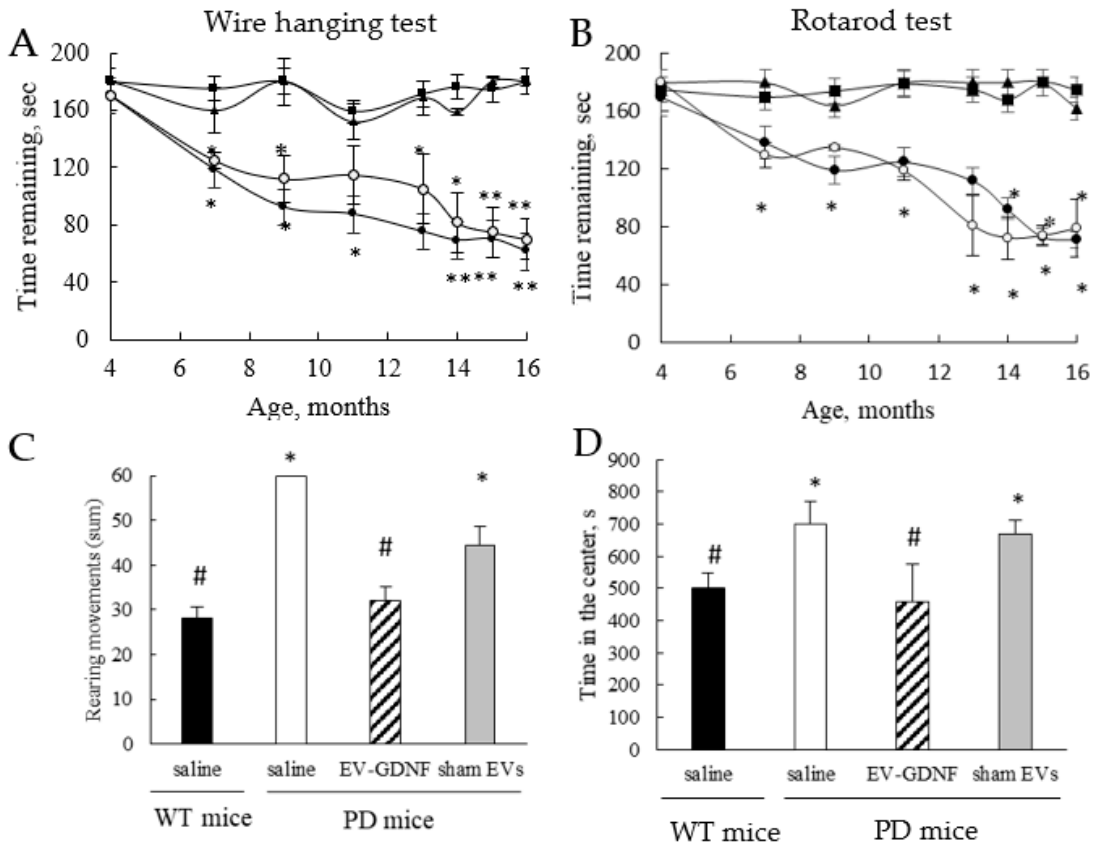
Figure 3. Behavioral tests demonstrating significant therapeutic effect of EV-GDNF in Parkin-Q311X(A) mice. The effect of EV-GDNF on motor functions and activity was assessed in a wire-hanging test and rotarod test ( A , B ), as well as in OFA tests ( C , D ). ( A , B ) Transgenic mice were i.n . injected with EV-GDNF (triangles, 3 × 10 9 particles/10 µL/mouse), or sham EVs (empty circles, 3 × 10 9 particles/10 µL/mouse), or saline (filled circles, 10 µL/mouse). Wild-type mice i.n . injected with saline (filled squares, 10 µL/mouse) were used as controls. Wire-hanging test ( A ), and rotarod test ( B ) demonstrated significant improvements in motor functions upon treatment with EV-GDNF. ( C , D ) OFA tests at 12 mo demonstrated improved behavior in EV-GDNF-treated PD mice (striped bars) compared to PD mice treated with saline (white bars), which was similar to healthy WT mice (black bars), including decreases in hyperactivity and anxiety-like behaviors. The differences between sham EVs and saline in PD mice were inconclusive. Values are means ± SEM ( n = 10), * p < 0.05, ** p < 0.005, and # p < 0.05, as compared to WT control mice injected with saline.